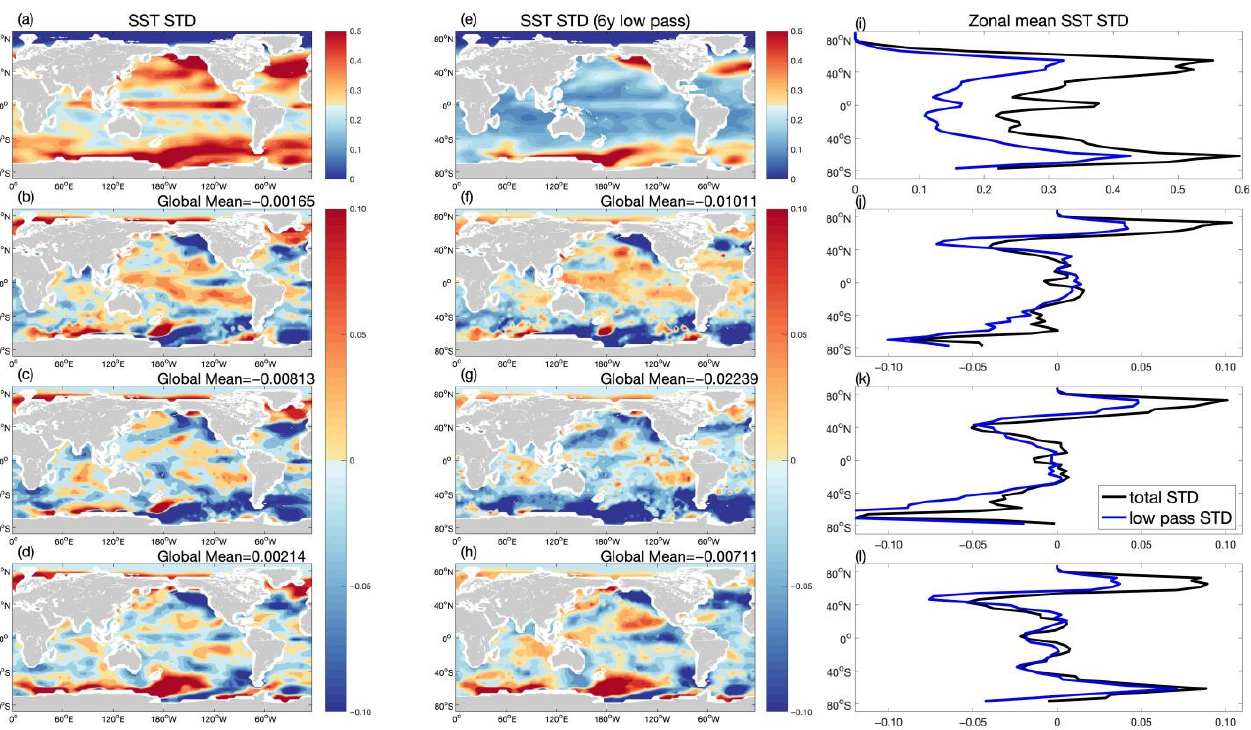
Figure 8. Standard deviation (STD) of unfiltered ( a ) and 6 yr low-pass filtered ( e ) annually averaged SST, and the zonal mean STD ( i ) in CTRL. ( b – d , f – h , j – l ) The differences between EQ, NE, OS, and CTRL, respectively. The global mean of the differences is shown in the upper right corner. The unit is °C.